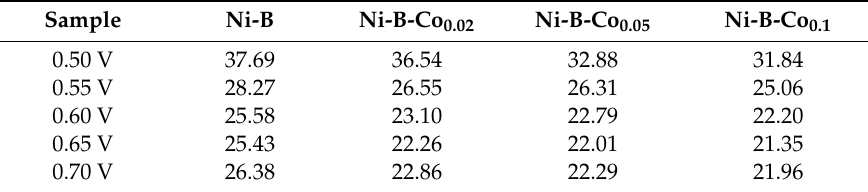
Table 4. The E a (kJ mol − 1 ) of methanol oxidation on the Ni-B and Ni-B-Co nanoparticles at different potentials.